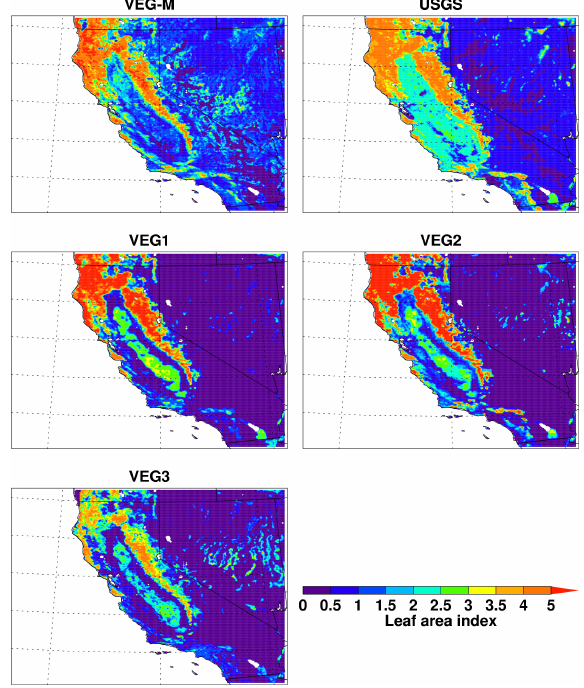
Figure 6. Spatial distribution of leaf area index (LAI) from the VEG-M in MEGAN v2.0 and from the USGS, VEG1, VEG2 and VEG3 in MEGAN